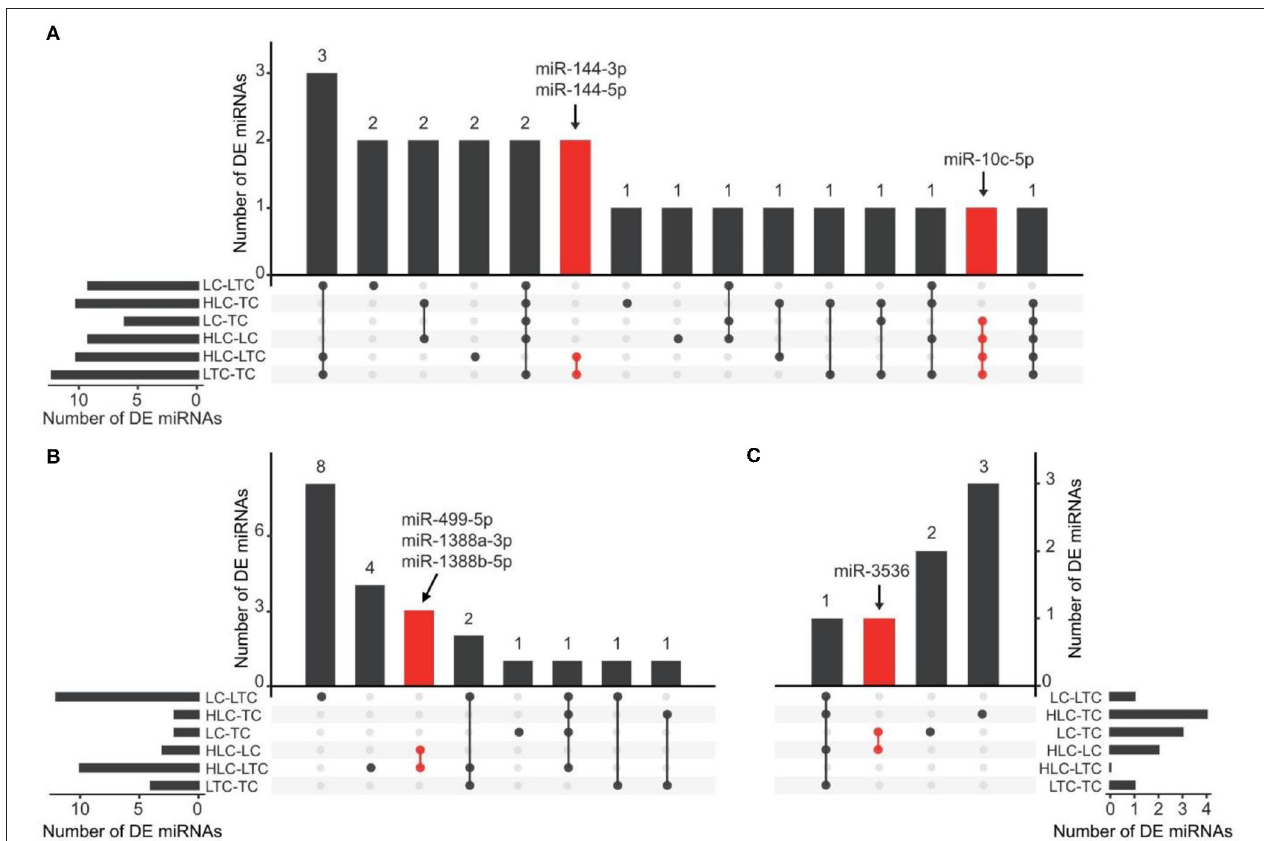
FIGURE 2 | UpSet plot showing the screening of candidate ENMs in the liver (A) , lung (B) , and heart (C) . The bars on the left or right of each panel were the numbers of DE miRNAs in each comparison of two groups of chickens. The dots represent relative DE miRNAs detected in the corresponding comparison. For example, in (B) , the red dots represent miRNAs detected to be differentially expressed in both two comparisons (HLC vs. LC, and HLC vs. LTC). Three and two candidate ENMs were obtained from the LC vs. HLC and LTC vs. TC comparisons,